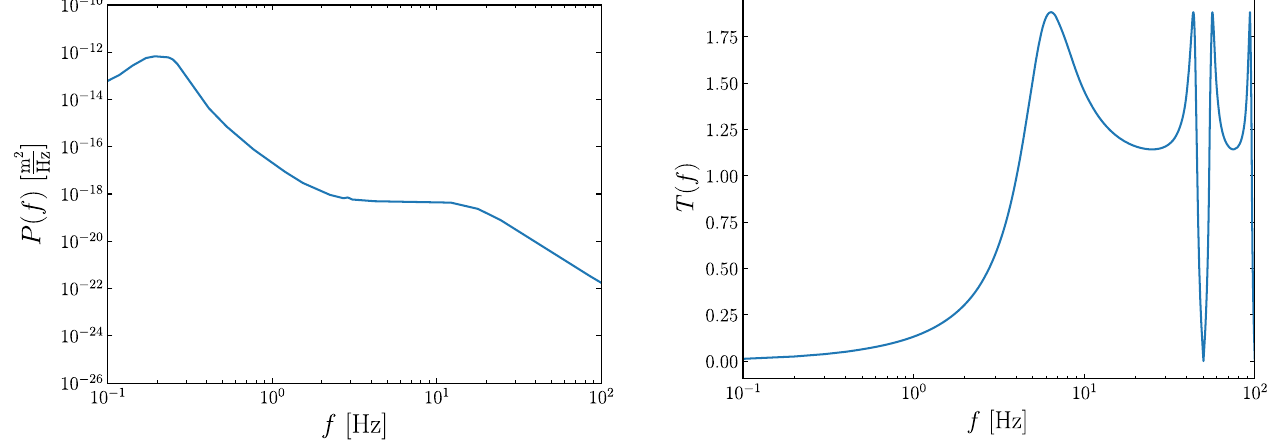
FIG. 12. Transfer function T ð f Þ vs frequency f for the beam- based feedback system used in CLIC.